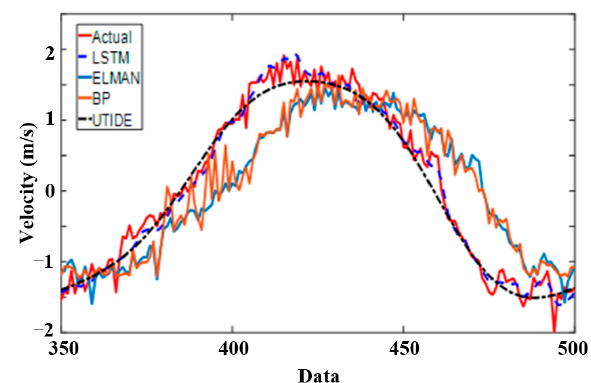
Figure 18. Enlarged figure of the comparison results in Figure 17.